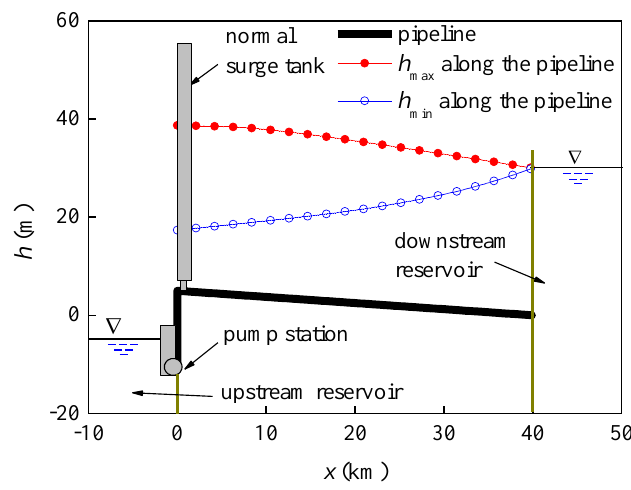
Figure 7. Extreme water head along the pipe after pump failure.